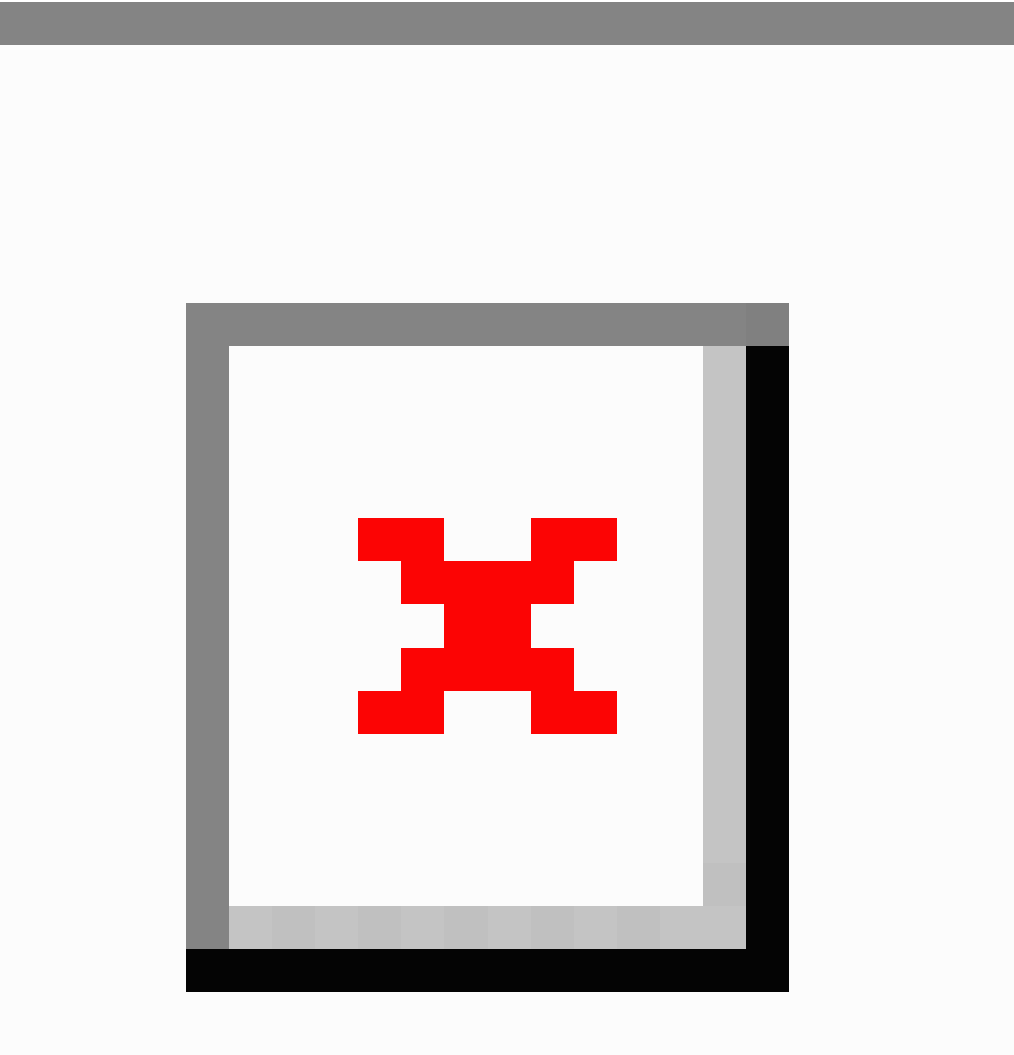
Figure 2. Histograms showing clinical measures of anxiety. Mean values at pre-treatment, post-treatment, and at 12-month follow-up. Error bars represent the standard